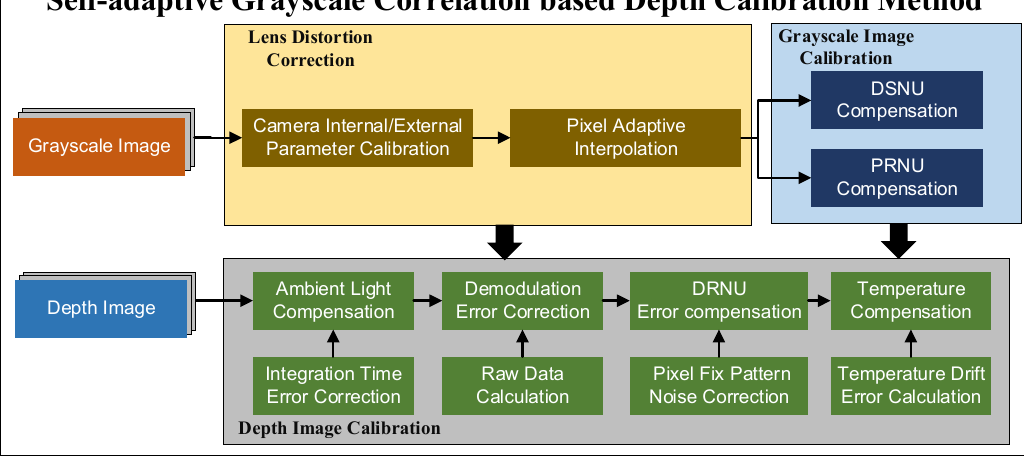
Table 1. Pixel adaptive interpolation strategy.